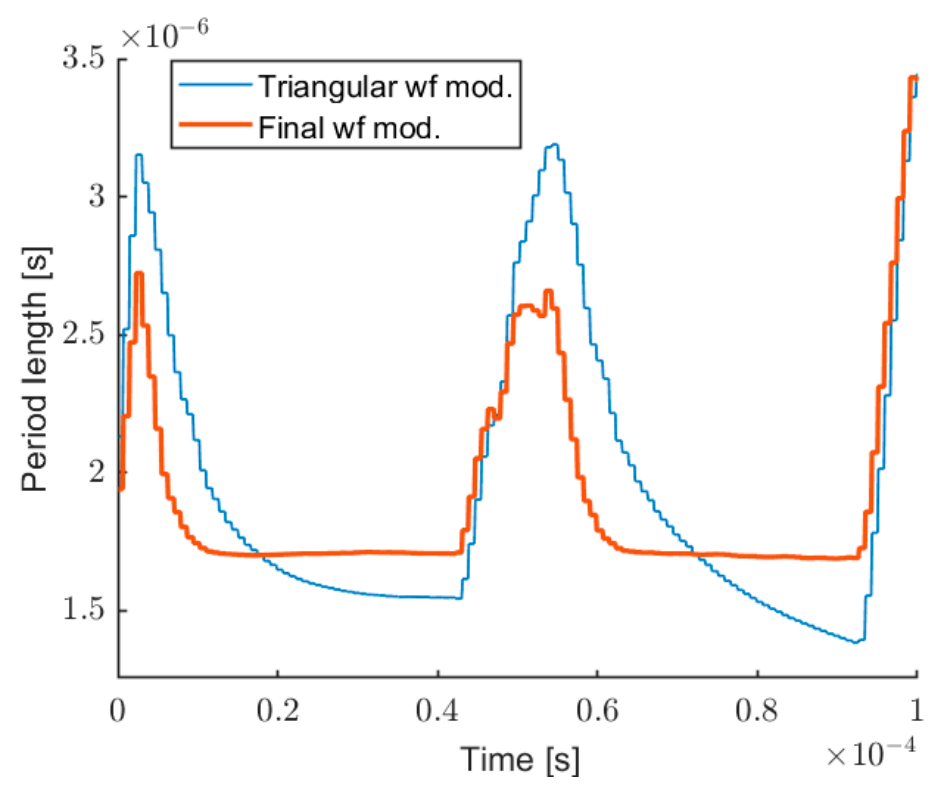
Figure 5. Period of the fringes before (thin line) and after (thick line) the distortion of the modulating